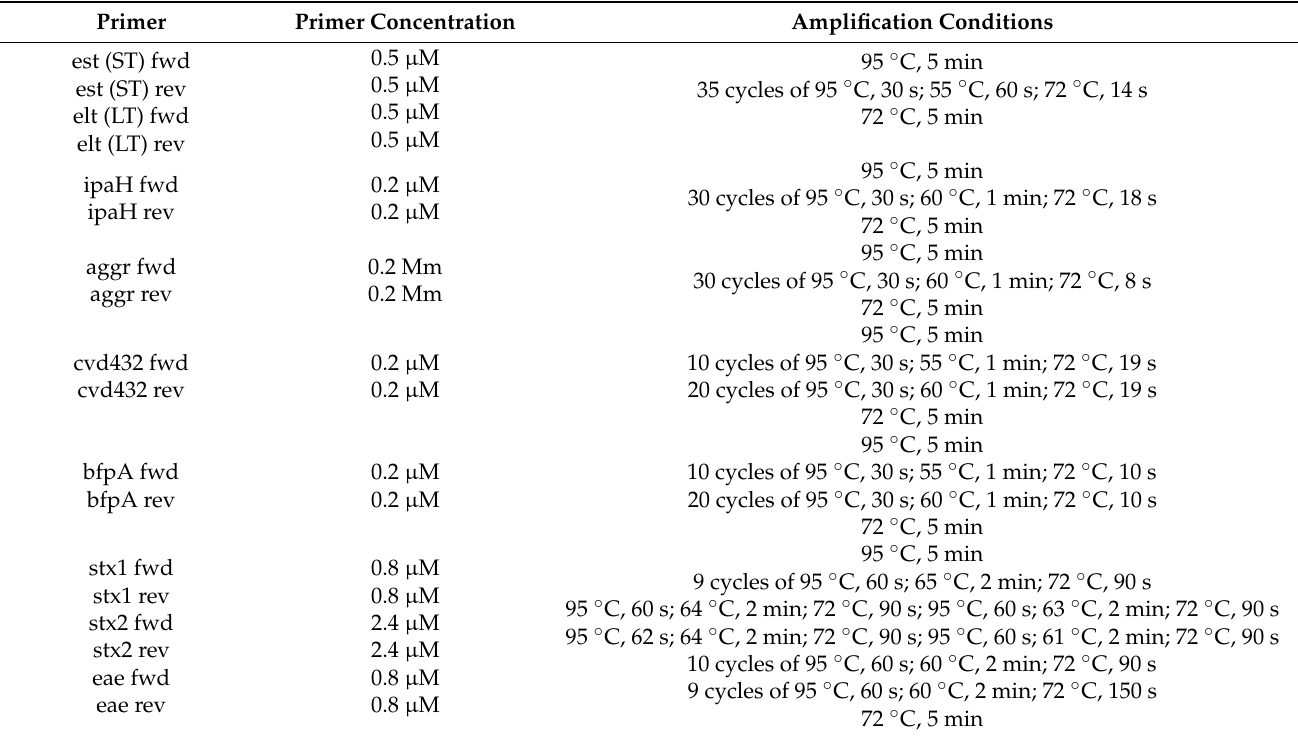
Table 12. List of concentrations of each primer, amplification conditions.